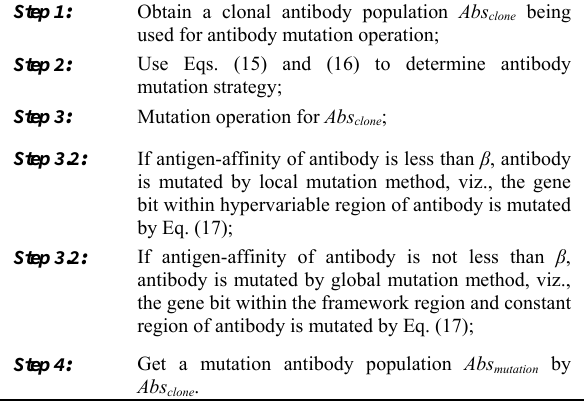
Algorithm 2. The antibody mutation algorithm